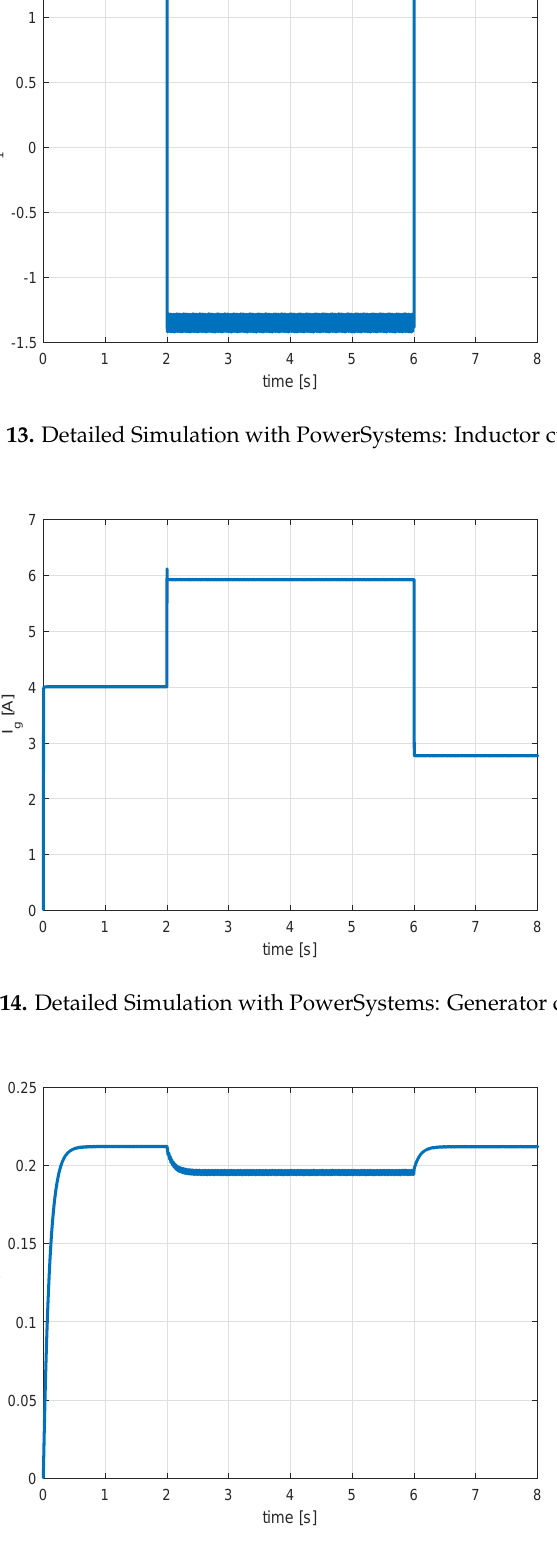
Figure 15. Detailed Simulation with PowerSystems: Average